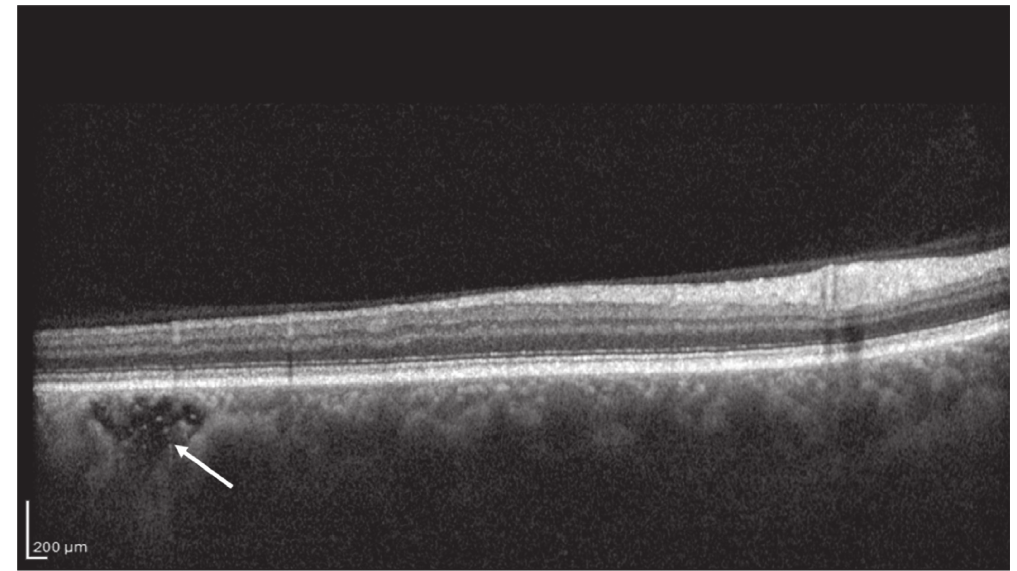
Figure 9: Structural biomarker: choroidal caverns (white arrow).